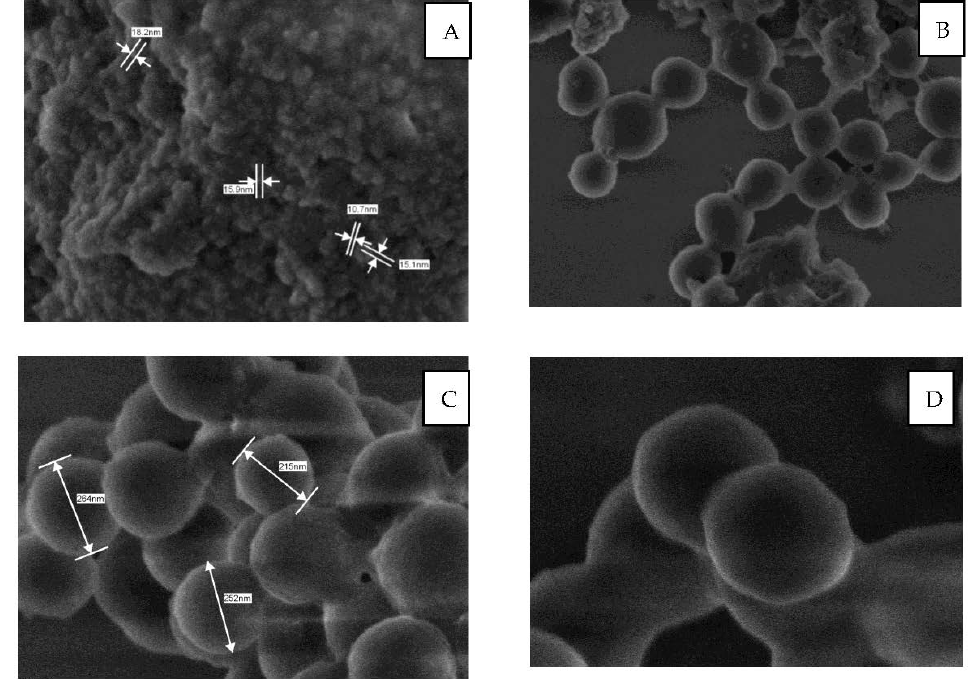
Figure 2. SEM images of ( A ) magnetite nanoparticles (Fe 3 O 4 ), ( B ) magnetite nanoparticles modified with silica Fe 3 O 4 @SiO 2 , ( C ) MMIPs, and ( D ) MNIPs prepared using the polyol method.